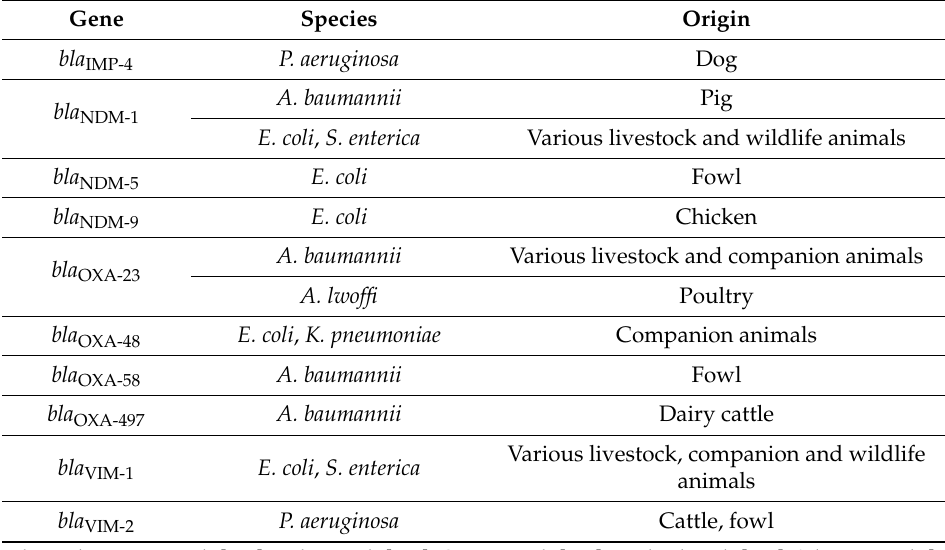
Table 6. Examples of carbapenemase genes found in Gram-negative bacteria from animals. Gene Species Origin bla